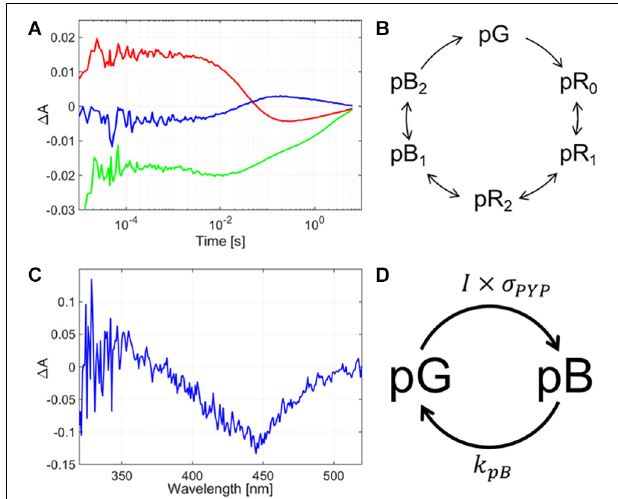
FIGURE 4 | (A) Absorption kinetics measurements and (B) intermediate accumulation measurements taken on a glycerol-containing PYP film. In subfigure (A) , the blue line represents the absorption spectrum measured at 360 nm, the green line at 430 nm, and the red line at 470 nm. In panel (B) , the difference absorption spectrum is shown, as measured after a 10-s excitation of the sample by a CW laser of 410 nm and 40 mW. (C) Schematic diagram of the full photocycle of a glycerol-containing PYP film. (D) Simplified diagram of the photocycle of the glycerol-containing PYP film showing only the states relevant for our pulsed Z-scan measurements. I is the (average) light intensity exciting the sample, σ PYP is the absorption cross section of the PYP molecule in the initial state, at the wavelength of excitation, and k PB is the rate constant of the pB-decay.